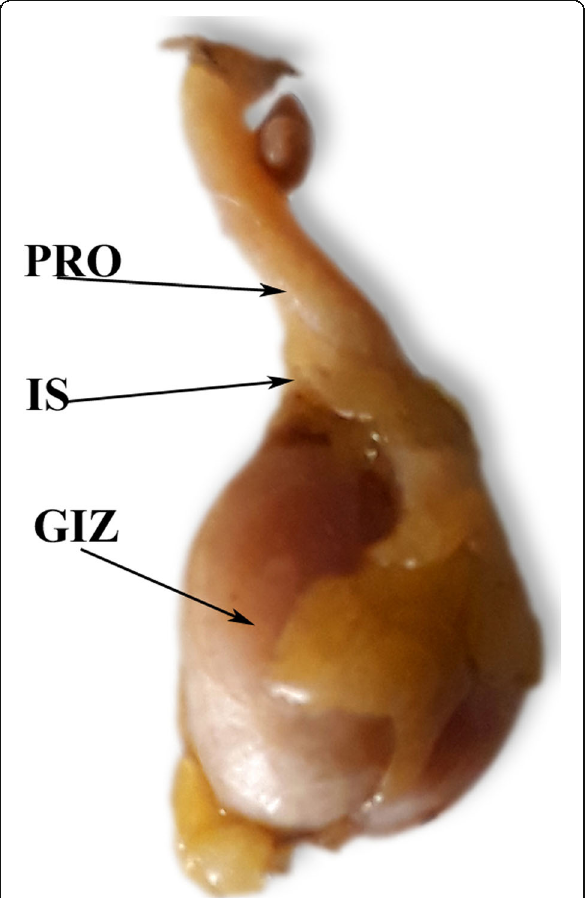
Fig. 9 The stomach in the zebra